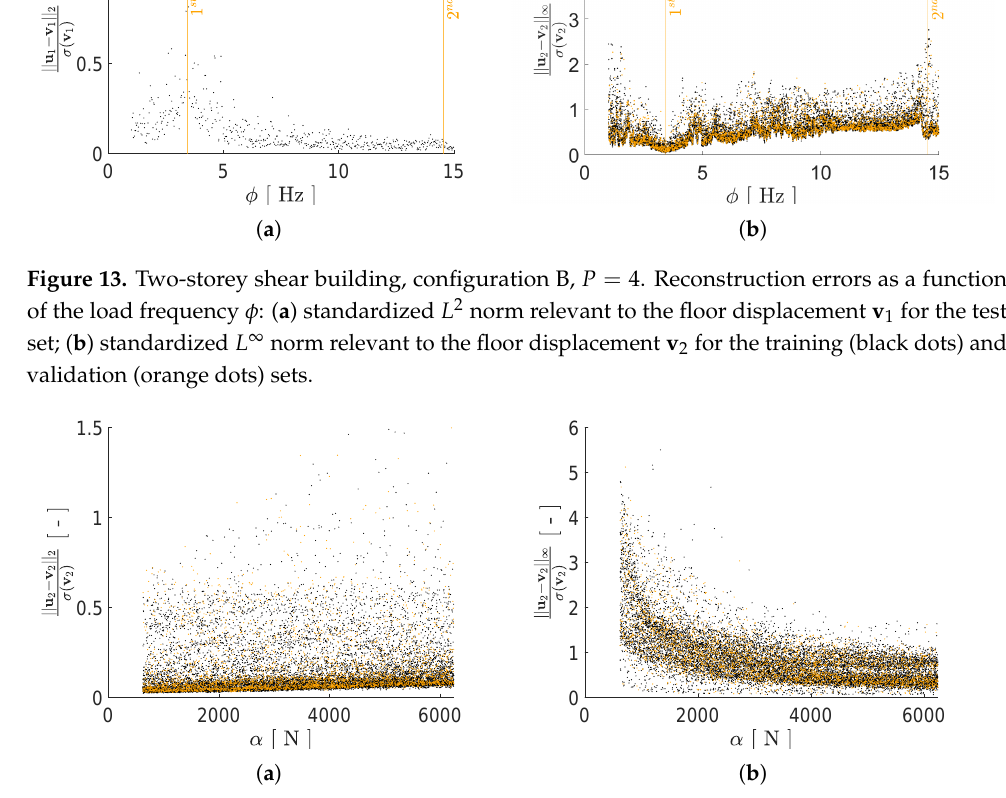
Figure 14. Two-storey shear building, configuration A, P = 4. Reconstruction errors as a function of the load amplitude α , relevant to the floor displacement v 2 for the training (black dots) and validation (orange dots) sets: ( a ) standardized L 2 norm; ( b ) standardized L ∞